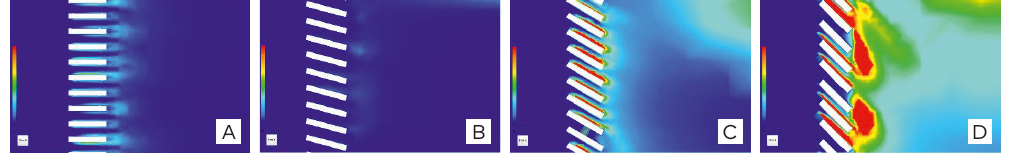
Figure 11. Energy growth per area of barrier with 20 mm thickness of mineral